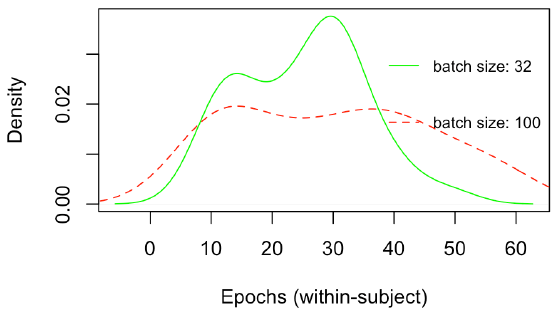
Figure 7. Comparison of the number of epochs to train the within-subjects CNN models, respectively, with batch size of dimension 32 and 100.